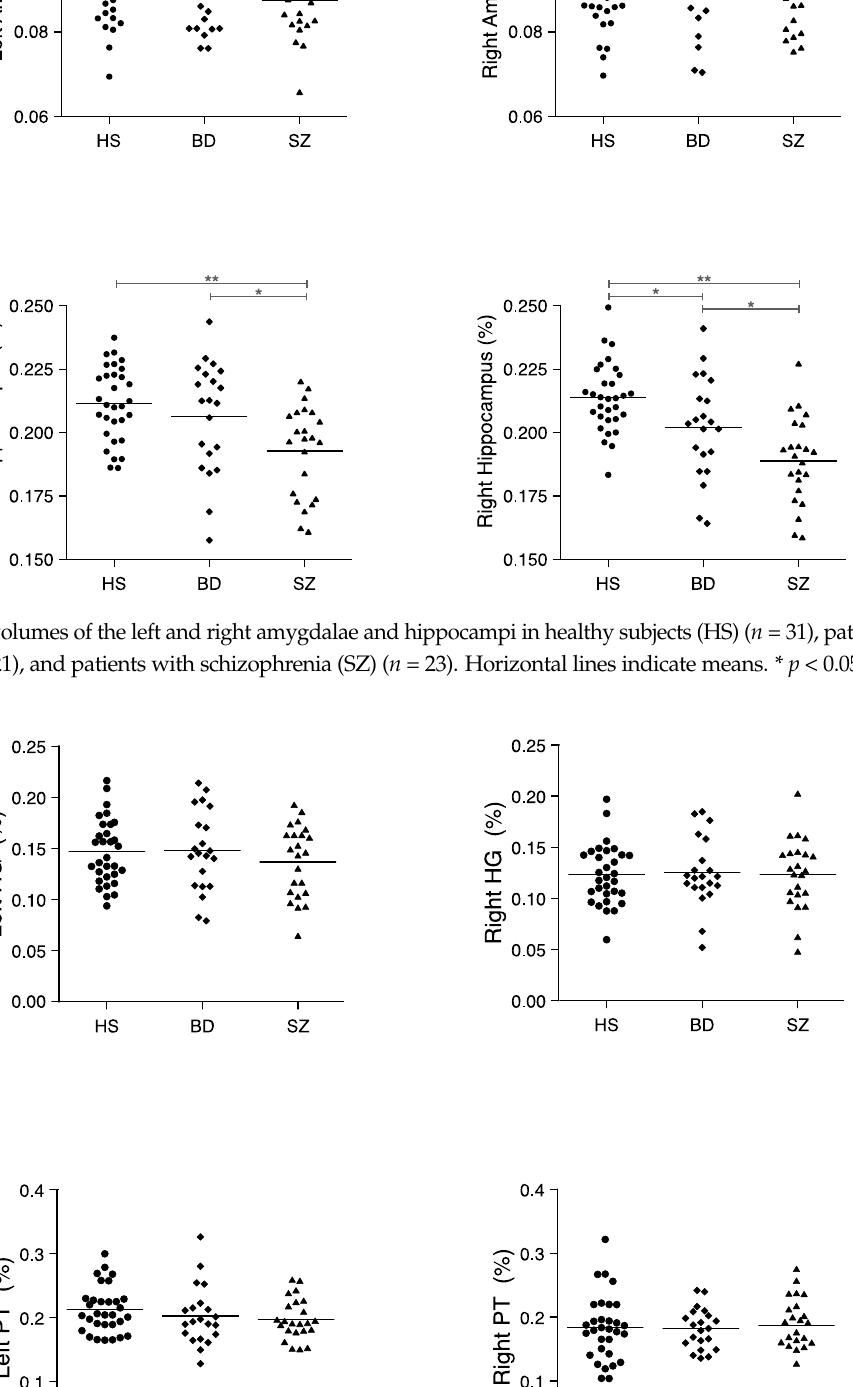
Figure 4. Receiver operating characteristic (ROC) curve of relative volumes of the right hippocampi between ( a ) HS and BD, ( b ) HS and SZ, and ( c ) BD and SZ. The area under the ROC curve was 0.69, 0.88, and 0.70, respectively. 4. Discussion We investigated the volumes of the hippocampi, amygdalae, HG, and PT in SZ pa- tients, BD patients, and HS. We found that right hippocampal volumes were lower in BD patients compared with controls, and further lower in SZ patients, whereas left hippo- campal volumes were lower exclusively in SZ patients. There were no significant differ- ences in either amygdala, HG, or PT among the three groups. Our results are consistent with many previous studies (e.g., [27,48]) although the re- cent study [14] of the direct comparison found no significant volume differences between the two groups. Our findings suggest that the lateralized hippocampal volume abnormal-